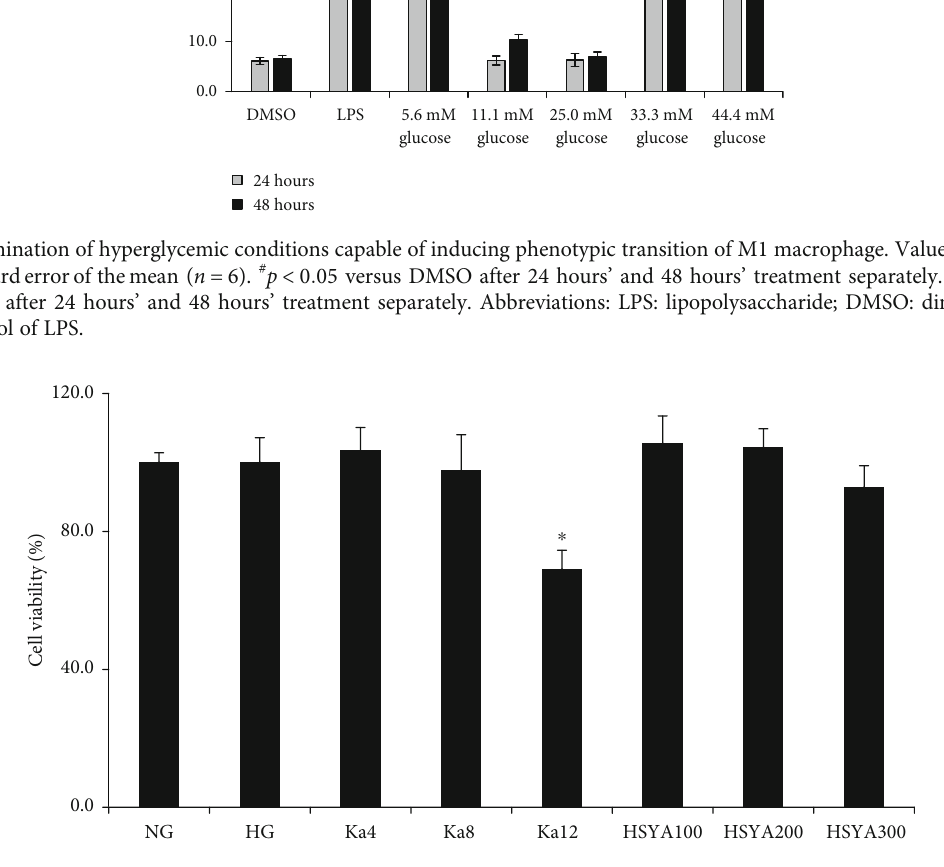
Figure 2: Determination of safety concentrations of Ka and HSYA in macrophages under hyperglycemic conditions with CCK-8 assay. ∗ p < 0 : 05 versus NG. Abbreviations: NG: 11.1mM glucose; HG: 33.3mM glucose; Ka4: kaempferol at 4 μ M; Ka8: kaempferol at 8 μ M; Ka12: kaempferol at 12 μ M; HSYA100: hydroxysa ffl or yellow A at 100 μ M; HSYA200: hydroxysa ffl or yellow A at 200 μ M; HSYA300: hydroxysa ffl or yellow A at 300 μ